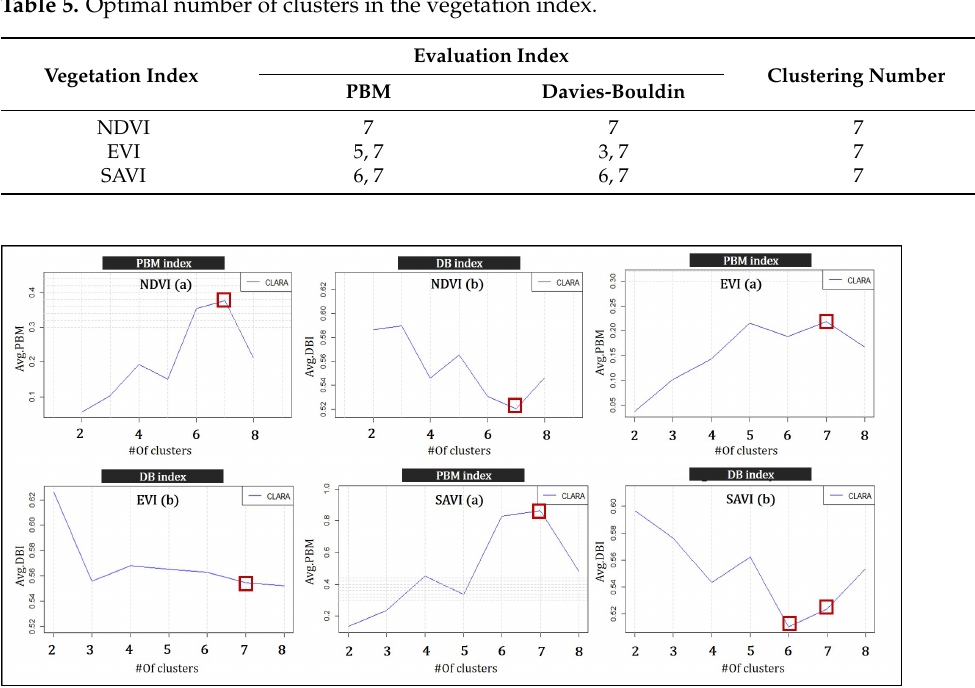
Figure 6. Internal evaluation results: ( a ) Pakhira–Bandyopadhyay–Maulik Index (PBM) ( b )